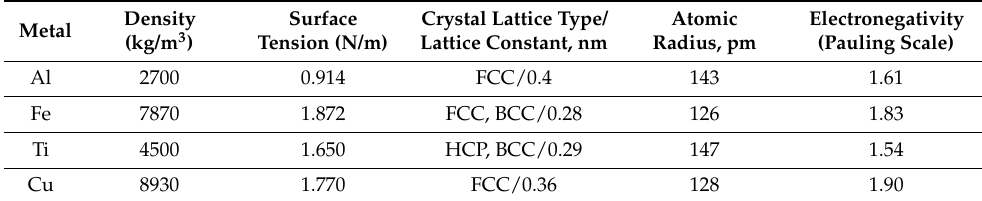
Table 2. Physical properties of Al, Fe, Ti, Cu